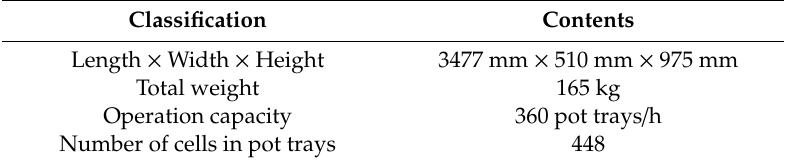
Table 1. Specifications of existing roller-type onion pot-seeding machine [11].